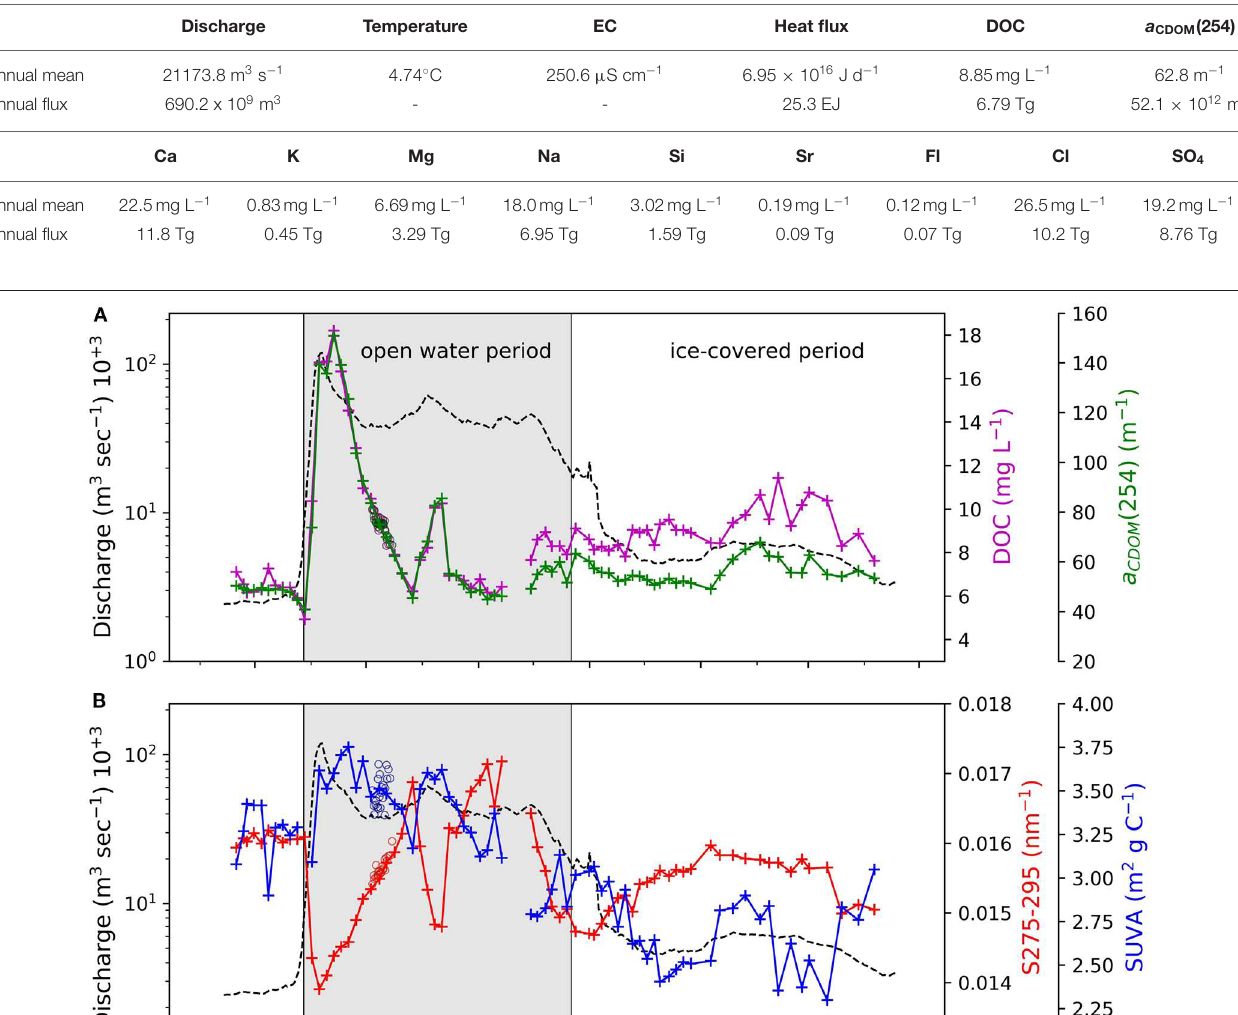
TABLE 3 | Annual mean values and annual fluxes of Lena River biogeochemical parameter.